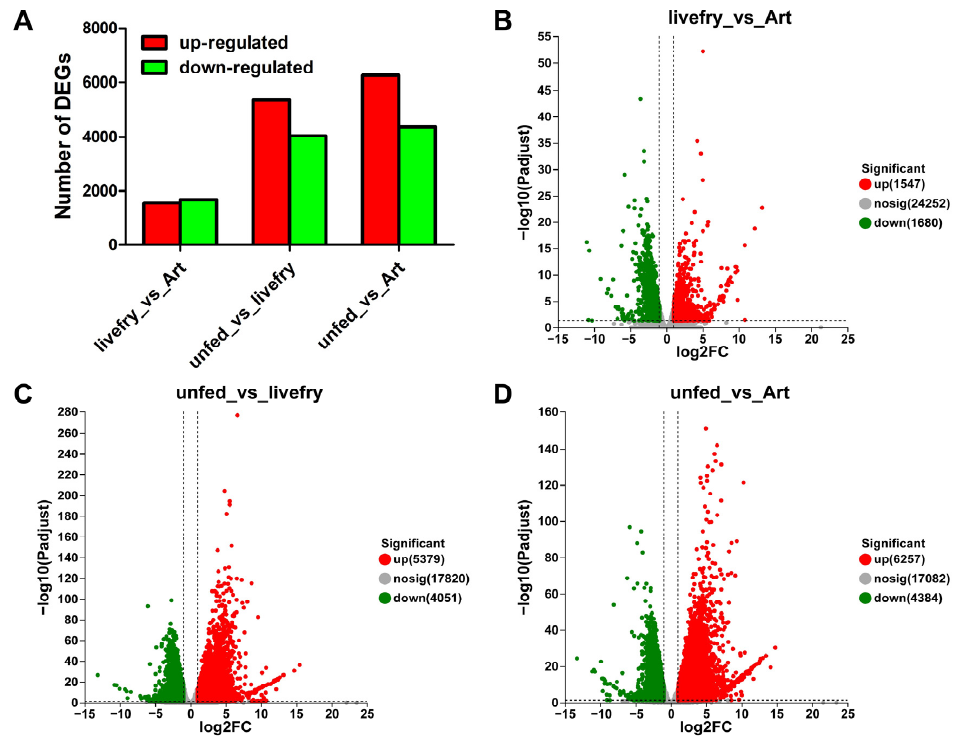
Figure 1. The statistics of differentially expressed genes (DEGs). ( A ). The number of DEGs; ( B ). Vol- cano plot of DEGs between the mandarin fish larvae fed with live prey fish and brine shrimp; ( C ). Volcano plot of DEGs between the mandarin fish larvae unfed and fed with live prey fish; ( D ). Volcano plot of DEGs between the mandarin fish larvae unfed and fed with brine